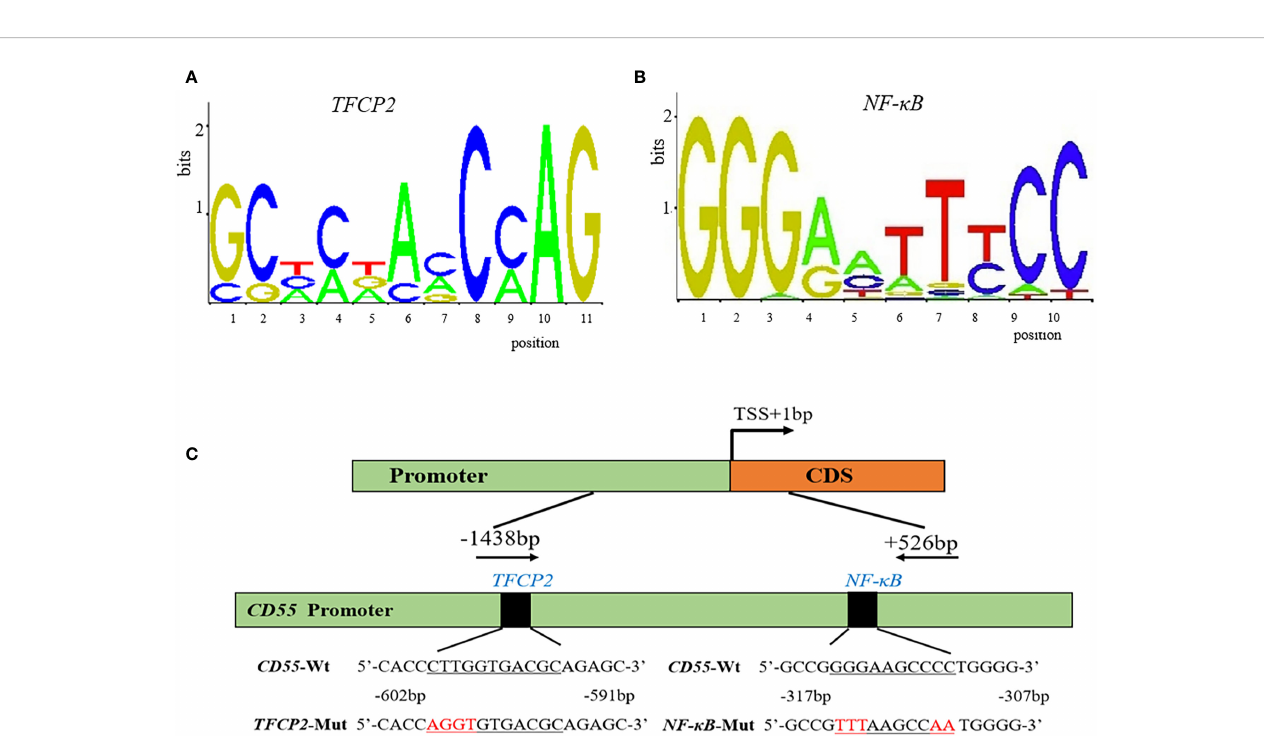
FIGURE 2 The potential binding sites and the diagram of the CD55 promoter. (A, B) The potential conserved sequence of TFCP2 and NF- k B binding site in the promoter of CD55 by Contra v3. (C) A diagram of the CD55 promoter region that was cloned in the luciferase reporter